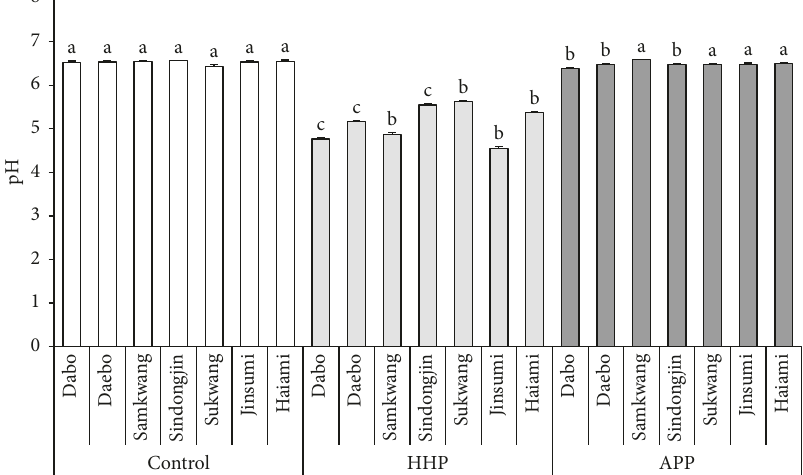
Figure 2: pH changes of rice. Samples were treated by high hydrostatic pressure or atmospheric pressure plasma, and pH changes were compared to control. Values with different superscripts are significantly different at p the same